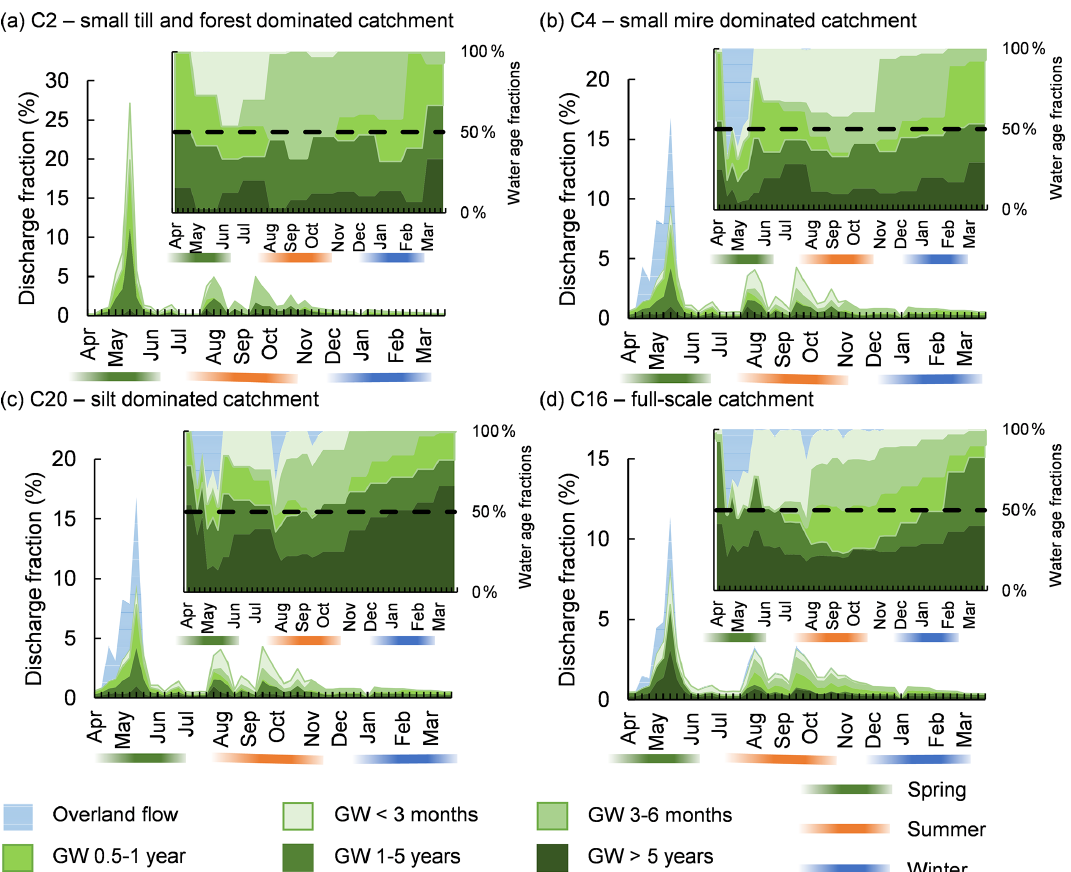
Figure 6. Seasonal fraction of discharge to streams. The figure shows the proportion of annual stream discharge arriving as groundwater and overland flow. Four sub-catchments are exemplified, including (a) the small till- and forest-dominated C2, (b) the small mire-dominated C4, (c) the silt-dominated C20, and (d) the full-scale Krycklan catchment C16 with mixed mires and forests (extended version in Appendix Fig. A1). The figure showcases the travel time fraction of water discharging to the streams. The fractions are both shown as part of the total annual discharge as well as the water composition. The bands below the months highlight the three investigated seasons, spring, summer, and